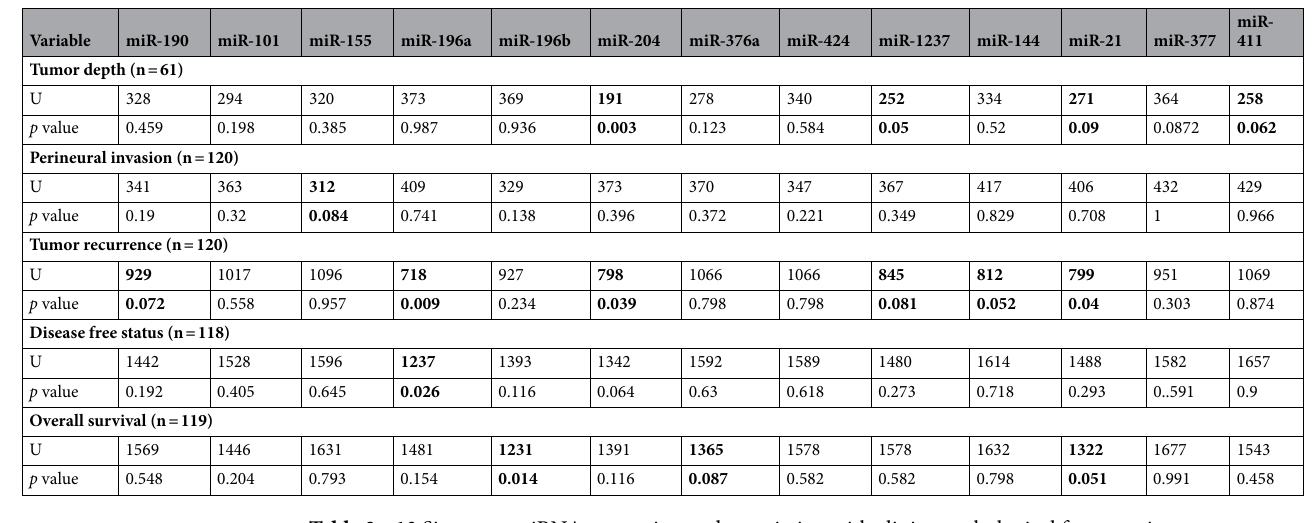
Table 3. 13 Signature miRNA expression and association with clinico-pathological factors using non- parametric Mann-Whitney U test. PNI perineural invasion. Bold values denotes the factors statistically siginificant with p value < 0.10.